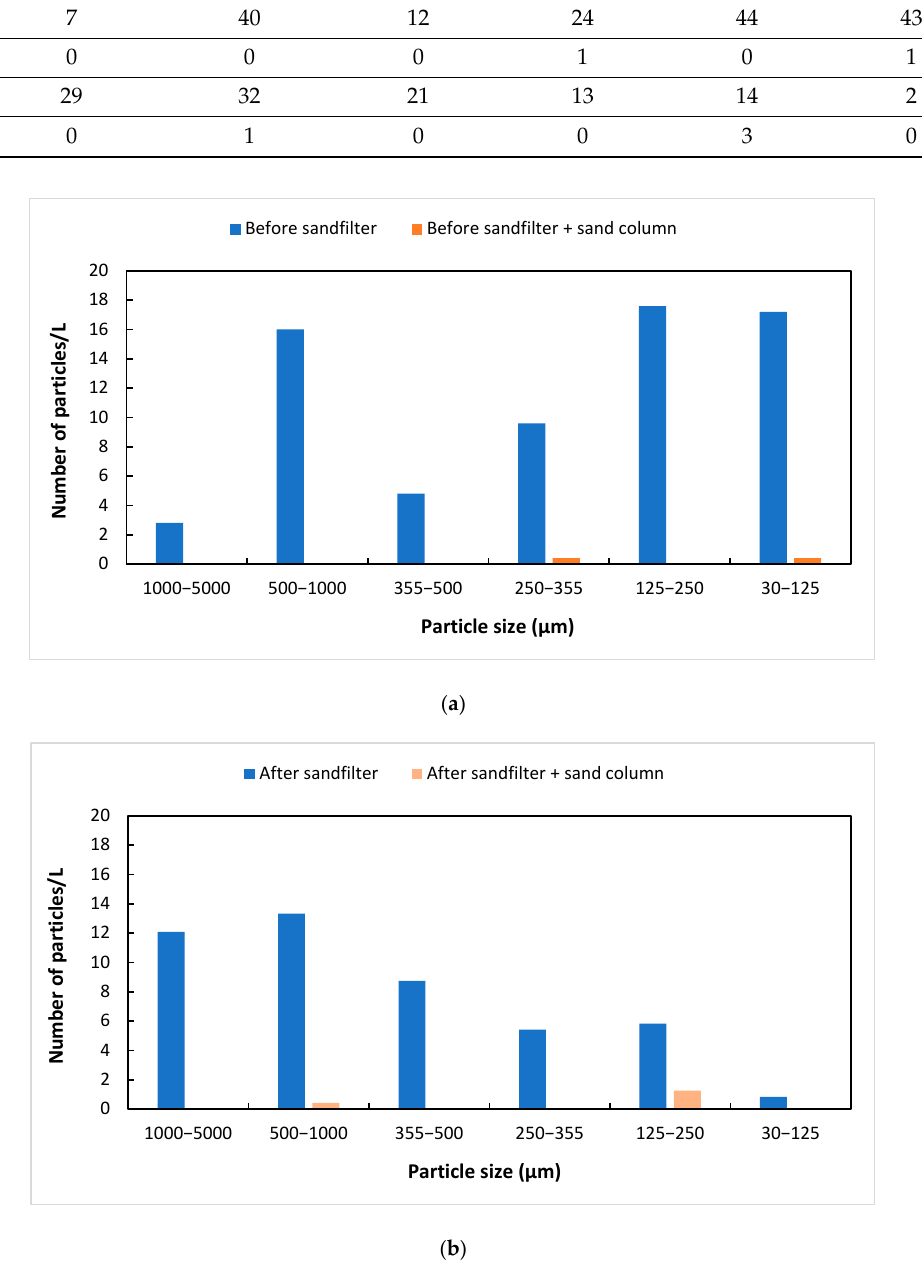
Figure 4. Concentration of synthetic fragments in untreated samples before and after sand column filtration: ( a ) untreated and ( b ) treated sample . The distribution of different polymers in both samples, before and after the sand- filter, is shown in Figure 5. As seen in Figure 5, PE and PP were the main microplastics present in the wastewater samples. A decrease in all MP fractions was observed after fil- tration using the laboratory-scale sand-filter.